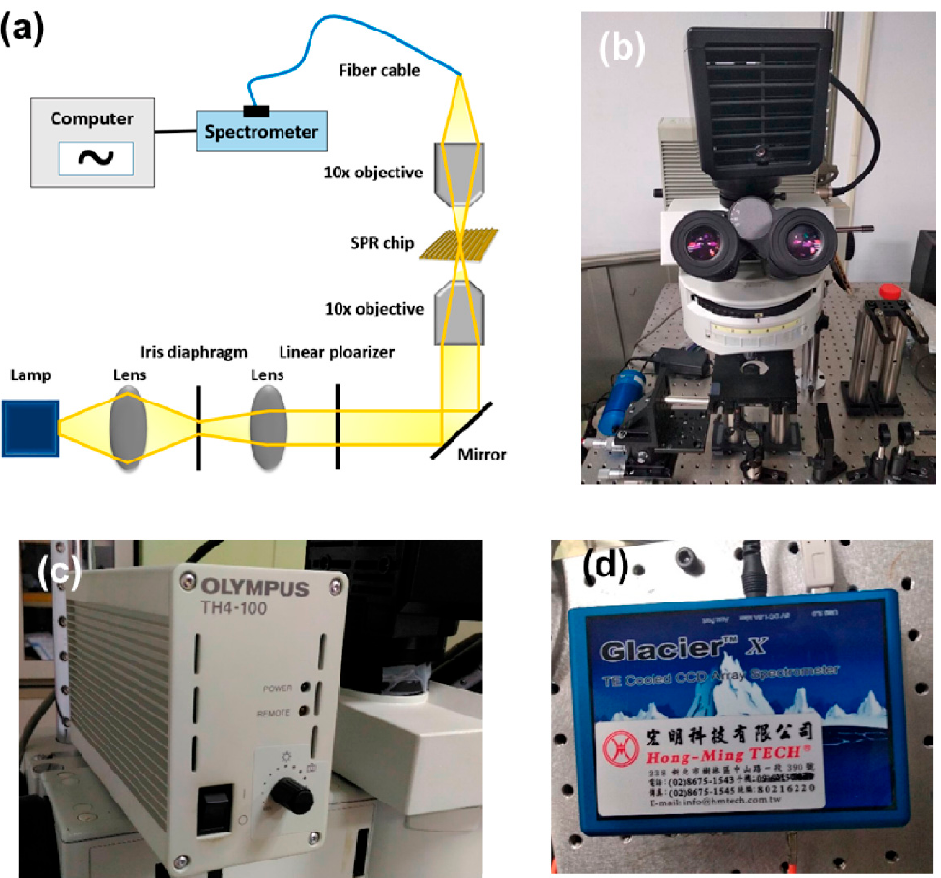
Figure 4. ( a ) Optical setup for a transparent type of nanoplasmonic biosensing device. ( b ) micro- scope ( c ) light source ( d ) spectrometer. ( c ) light source ( d )